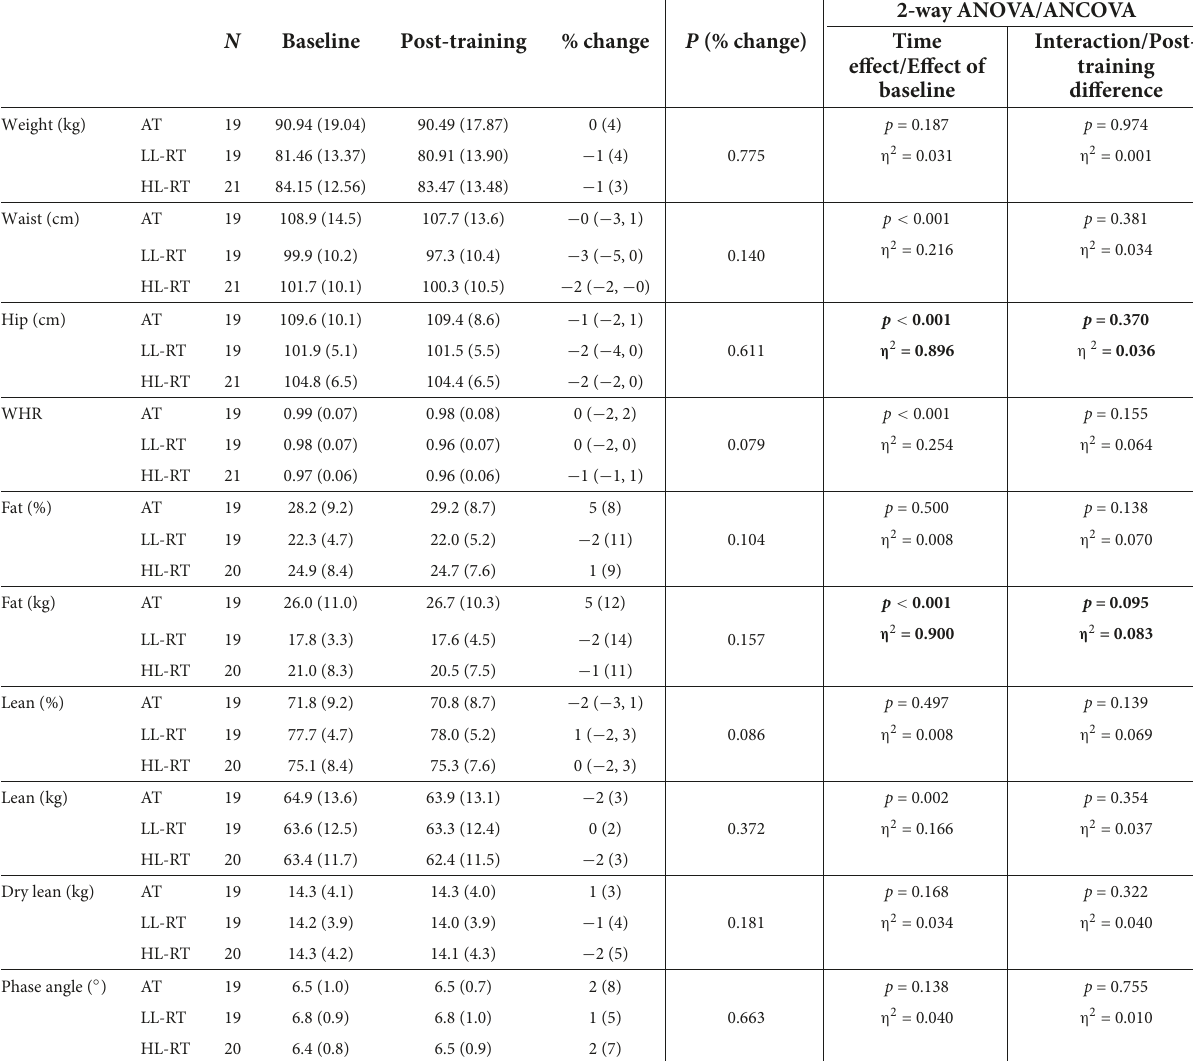
TABLE 2 Body composition at baseline and